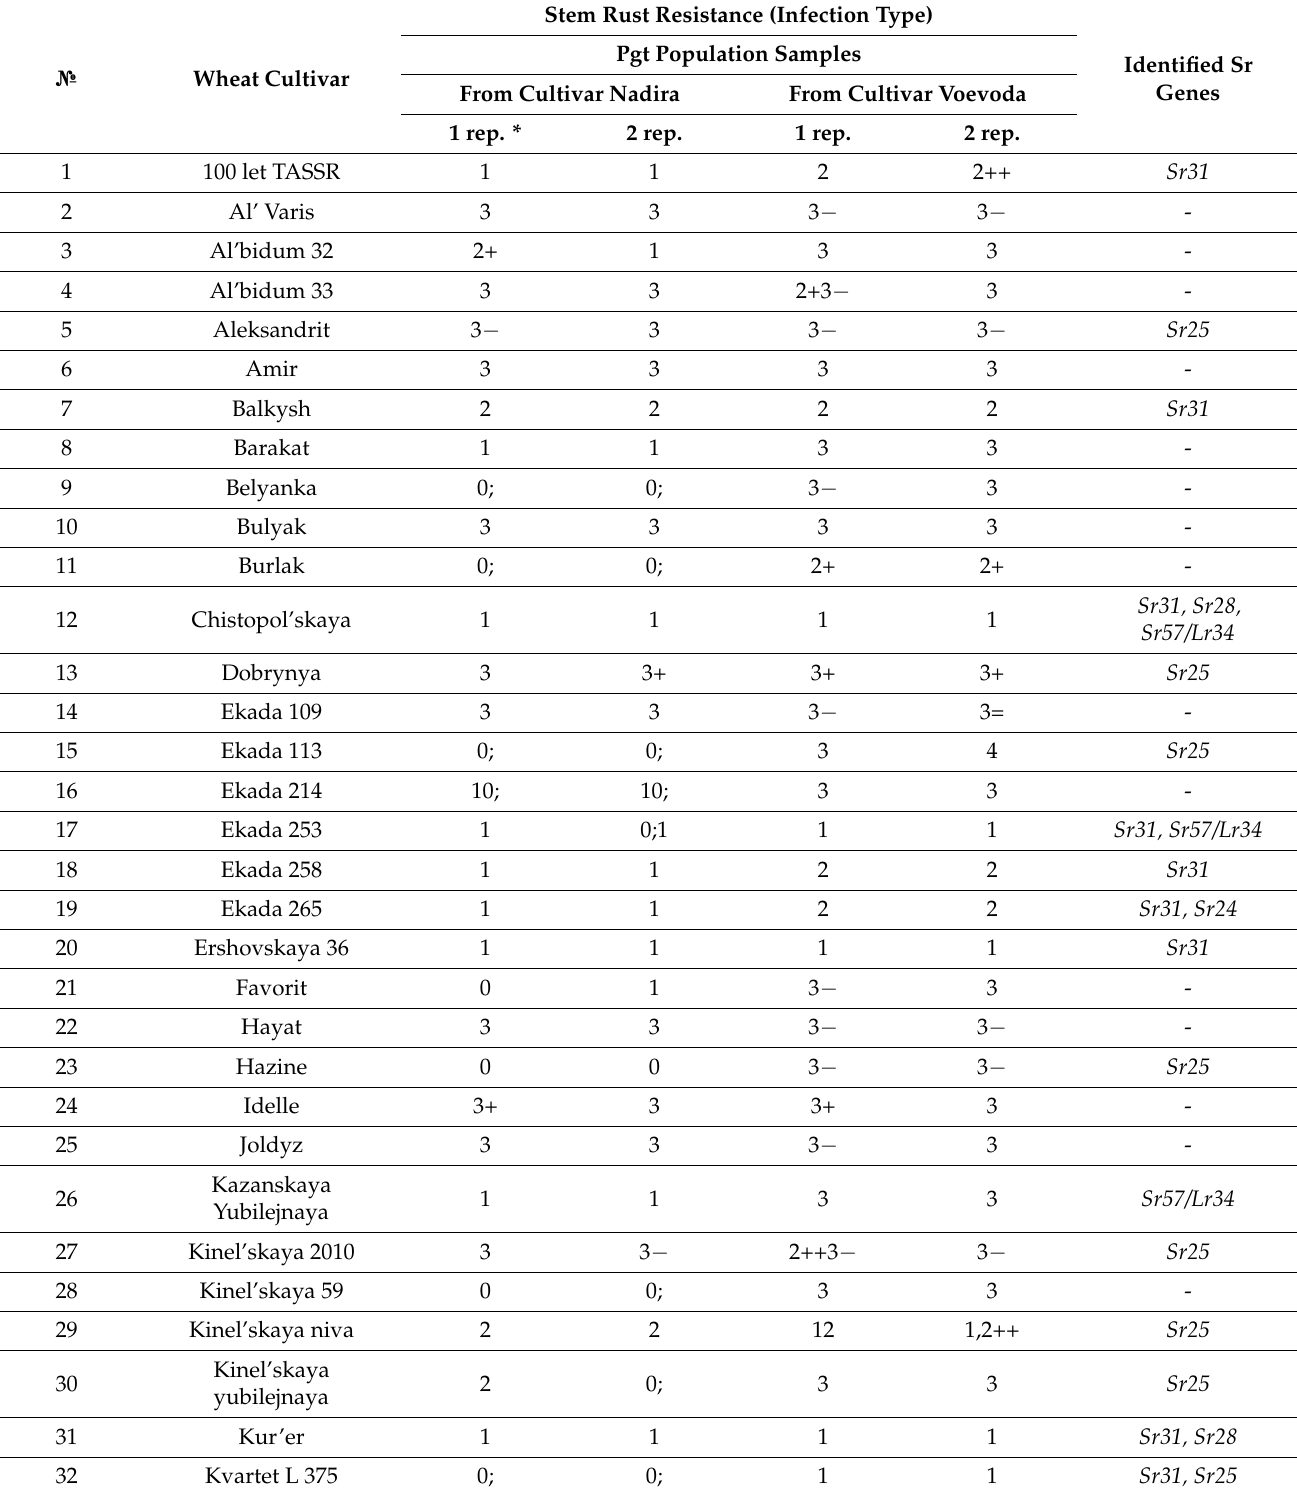
Table 3. Evaluation of resistance to stem rust and identification of Sr genes in spring bread wheat cultivars in the Volga